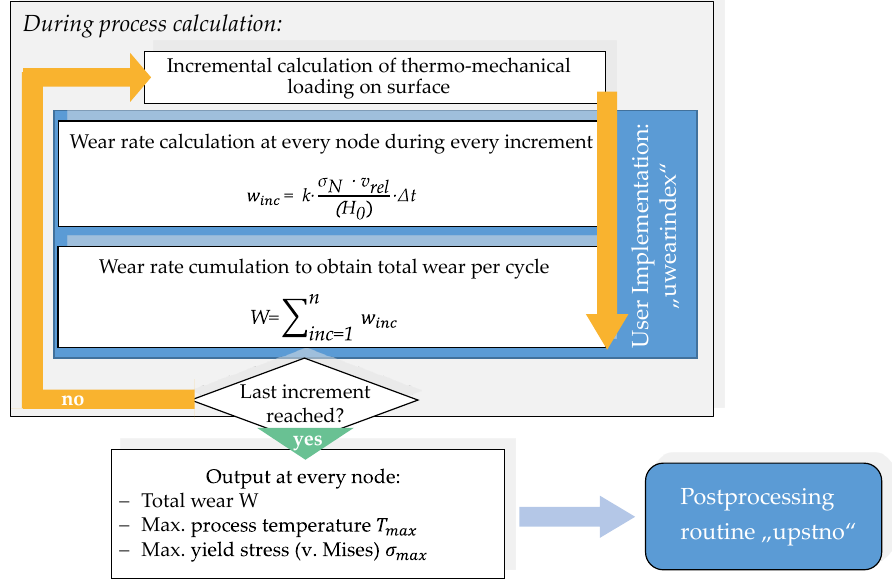
Figure 5. Basic wear implementation during process calculation.